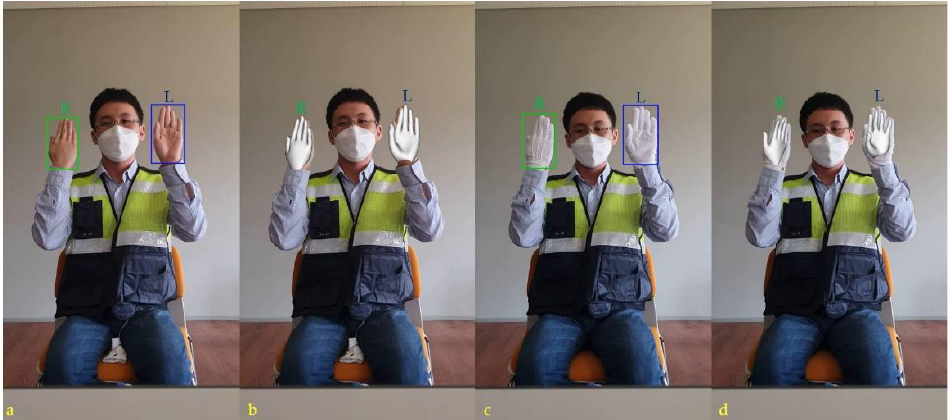
Figure 9. Left ( L ) and right ( R ) hand–palm detection. ( a ) Left and right hands without gloves; ( b ) the corresponding 3D hand model. ( c ) Left and right hands with gloves; ( d ) the corresponding 3D hand